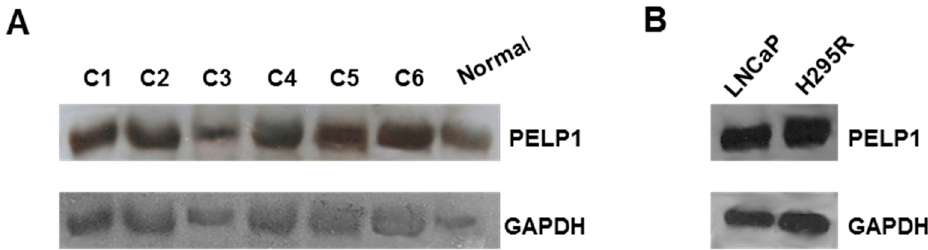
Figure 1. PELP1 expression in human tissues of ACC and H295R cells. ( A ) Western blot analysis of PELP1 was performed on 50 µ g of total protein extracted from normal human adrenal tissues (normal) and ACCs (C1–C6); ( B ) Western analysis of PELP1 was performed on 50 µ g of total protein extracted from LNCaP and H295R cells. GAPDH was used as a loading control. Results are representative of three different experiments.